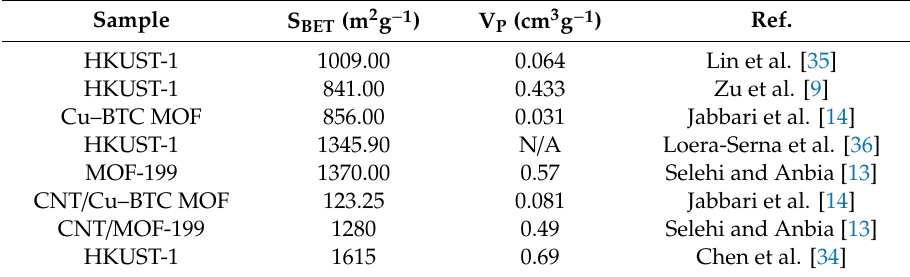
Table 1. Textural properties of Cu–BTC metal–organic framework (MOF) (Hong Kong University of Science and Technology (HKUST-1)) synthesized using the hydrothermal